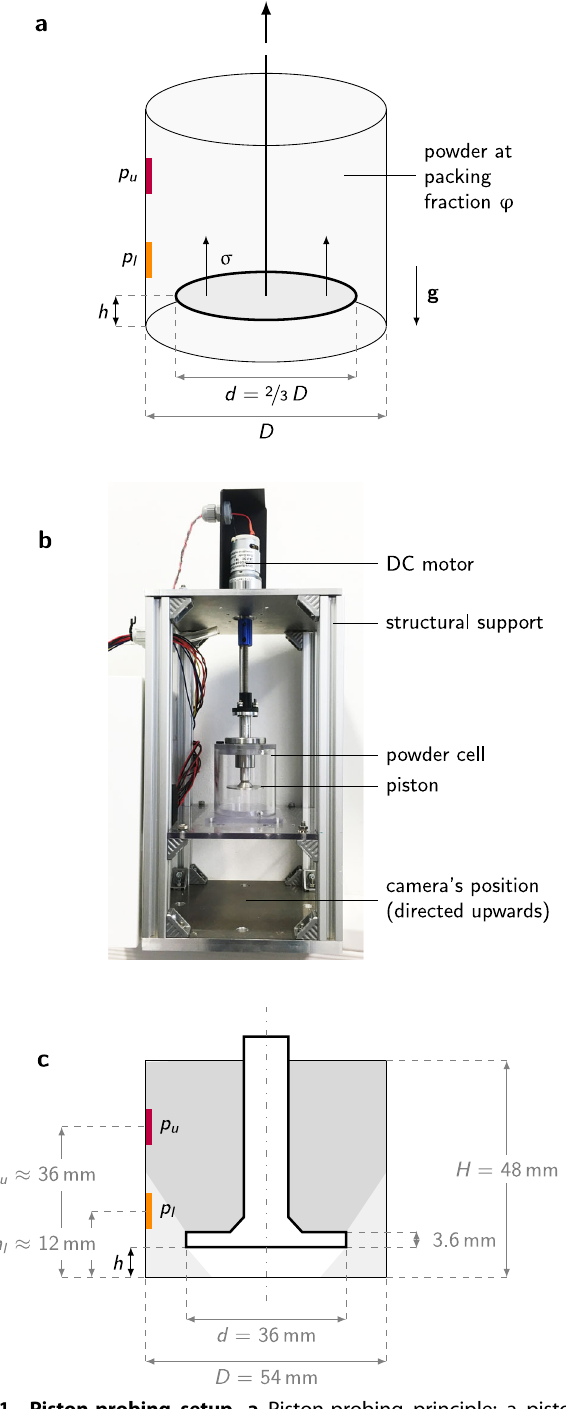
Fig. 1 Piston-probing setup. a Piston-probing principle: a piston rises incrementally in a closed container, fi lled with powder at packing fraction φ , applying a normal stress σ on the granular packing. The pressure p transmitted through the granular material is recorded by two pressure sensors placed on the lateral walls of the container (respectively recording p u and p l , upper and lower pressures). The direction of the gravitational acceleration g is indicated by a downwards-pointing arrow. b Experimental setup, showing the container (here empty) in its support structure (photograph taken by the authors). c Schematic including contain- er ’ s and piston ’ s dimensions (in gray), and variables recorded (in